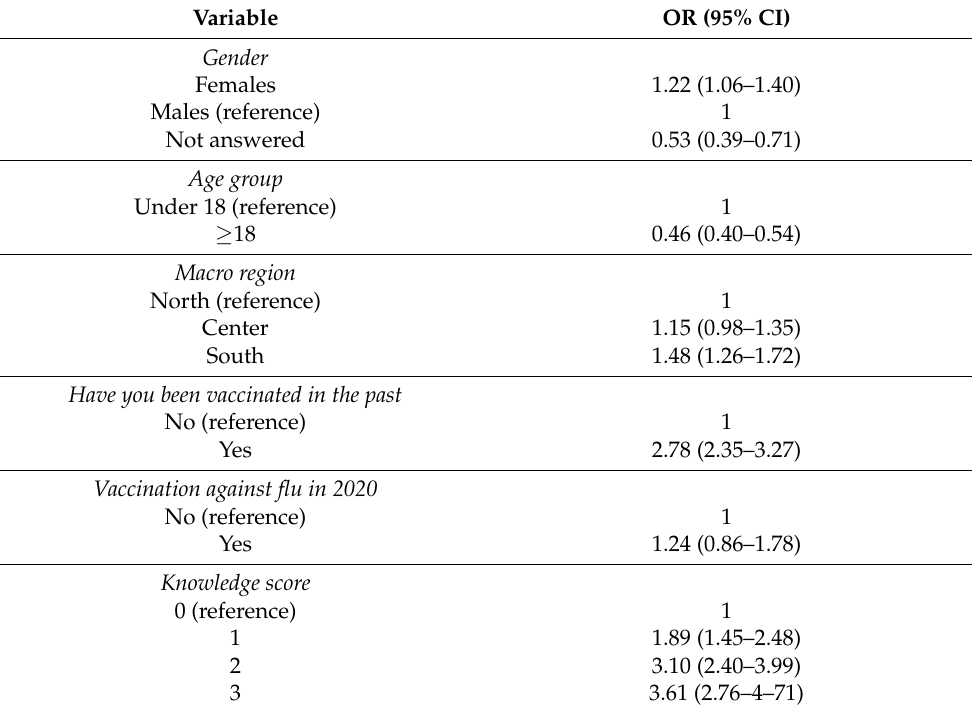
Table 4. Multivariate analysis with dependent variable of willingness to be vaccinated against